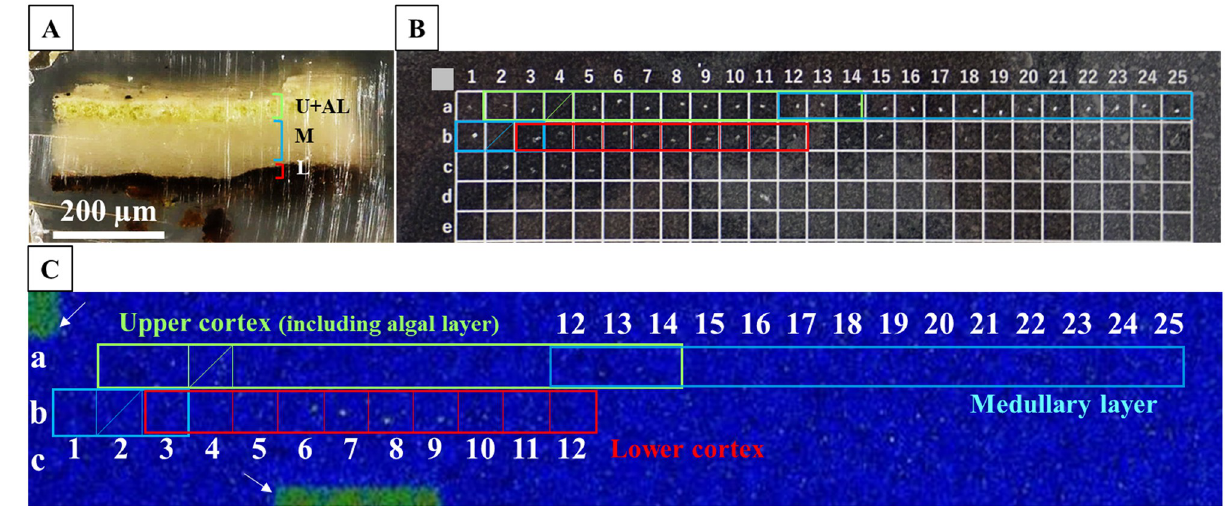
Fig 5. Radiocaesium distributions in the tissue sections of the FY2017PT thallus selected from fragment in Fig 2 showing broad distributions. (A) Cross-sectional image of the FY2017PT lichen thallus tissue embedded in resin before microtome slicing. The thallus tissue was prepared from the broad distribution “a” of the FY2017PT sample in Figs 1 and 2. U+AL, upper cortex including the algal layer; M, medullary layer; L, lower cortex. (B) 5 μ m-thick tissue sections of lichen thallus on a square-shaped cell plate. Coloured frames are sections containing tissue. Green, aqua and red boxes indicate the areas corresponding to the upper cortex (including the algal layer), medullary layer and lower cortex, respectively. Overlapping boxes indicate that two layers were contained in the frames. The boxed areas without a coloured frame are empty sections containing only resin and no tissue. Shaded areas, i.e., “a-4” and “b-2”, are missing numbers. The “b-3” layer contains 2 sections. (C) Autoradiograph images of each tissue section on the cell plate. Block numbers are the same as those in (B). White arrows indicate marks used to determine the locations of the cell plate boxes. The sections were exposed for 14 days on the IP. Significant radiocaesium distributions were detected in sections “b-4” to “b-9” corresponding to the lower cortex.